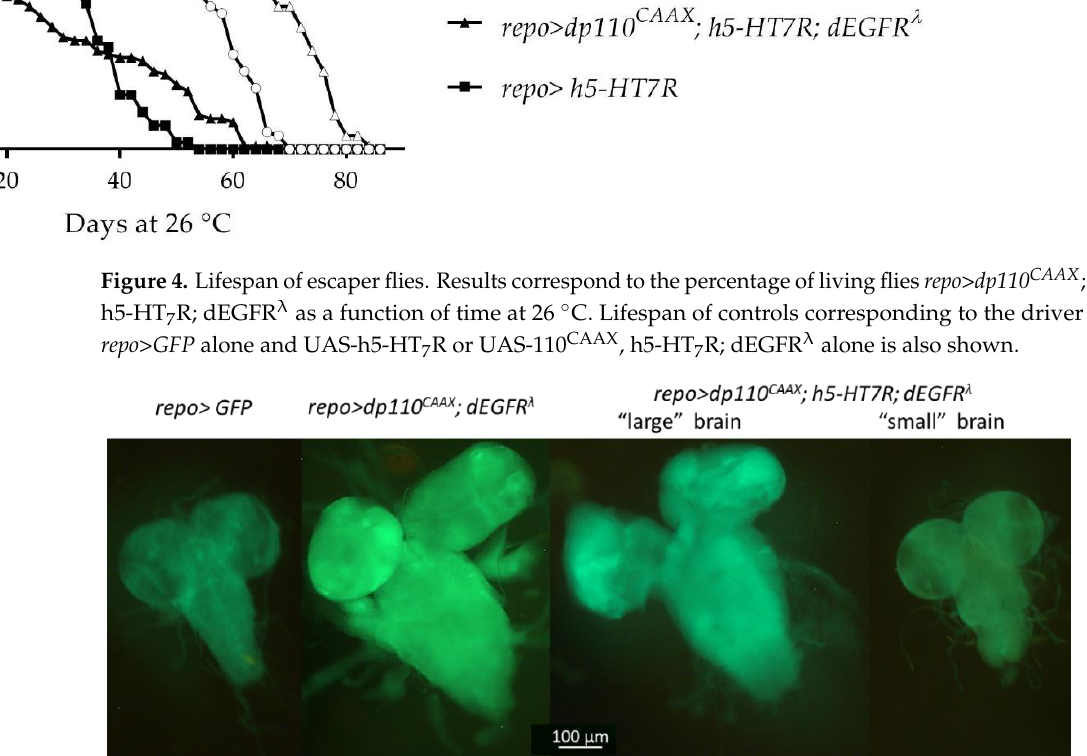
Figure 5. h5-HT7R expression reduces proliferation in glioma. Fluorescence microscopy images of third instar larval brains. Larvae expressing h5-HT7R in a glioma context (repo>dp110 CAAX ; h5- HT7R; dEGFR λ ) exhibit brains of different sizes: “large” brains look like glioma (repo>dp110 CAAX ; dEGFR λ ), “small” brains look like controls (repo>GFP). Green fluorescent protein (GFP) is expressed in glial cells.